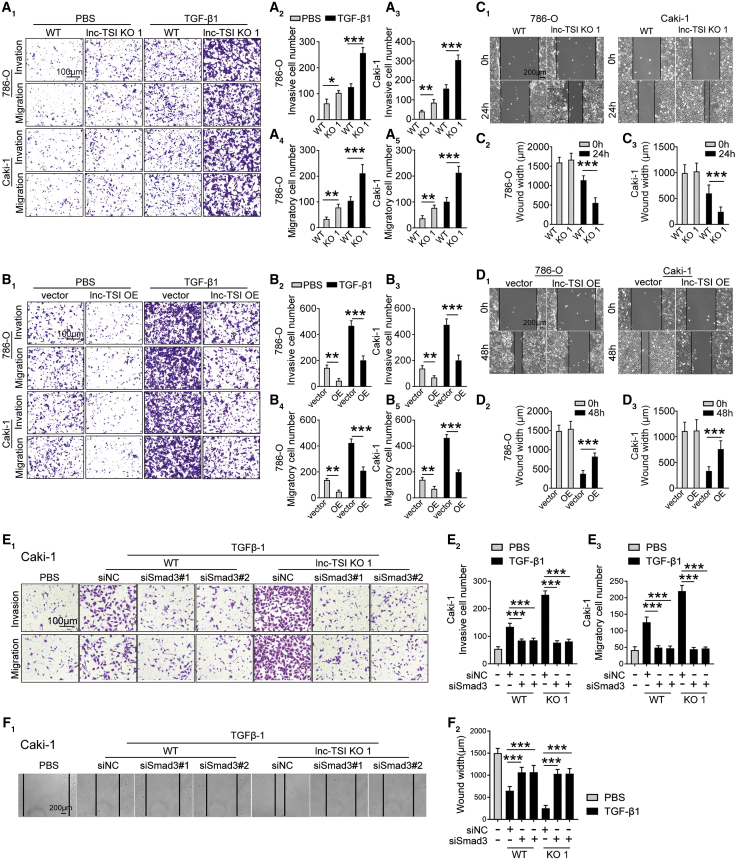
lnc-TSI Inhibits TGF-β1-Induced Invasion and Metastasis in ccRCC Cells(A) The representative images of Transwell assays (A1) and the data analysis results (A2–A5) showed that knockout of lnc-TSI enhanced cell migration and invasiveness in 786-O and Caki-1 cells compared to controls. 786-O and Caki-1 cells were treated with TGF-β1 (10 ng/mL) for 48 h. (B) The representative images of Transwell assays (B1) and the data analysis results (B2–B5) showed that overexpression of lnc-TSI inhibited cell migration and invasiveness in 786-O and Caki-1 cells compared to cells transfected with empty vector. 786-O and Caki-1 cells were treated with TGF-β1 (10 ng/mL) for 72 h. (C) Representative images of wound-healing assays (C1) and the data analysis results (C2 and C3) showed that knockout of lnc-TSI increased cell migration in both 786-O and Caki-1 cells compared to controls. (D) Representative images of wound-healing assays (D1) and the data analysis results (D2 and D3) showed that overexpression of lnc-TSI decreased cell migration in 786-O and Caki-1 cells compared to cells transfected with empty vector. (E) Representative images of Transwell assays (E1) and the data analysis results (E2 and E3) showed that knockdown of Smad3 inhibited cell migration and invasiveness induced by TGF-β1 stimulation in Caki-1 cells with or without lnc-TSI knockout. (F) Representative images of wound-healing assays (F1) and the data analysis results (F2 and F3) showed that knockdown of Smad3 inhibited cell migration induced by TGF-β1 stimulation in Caki-1 cells with or without lnc-TSI knockout. Data are expressed as means ± SD of three independent experiments. ∗p < 0.05, ∗∗p < 0.01, ∗∗∗p < 0.001.